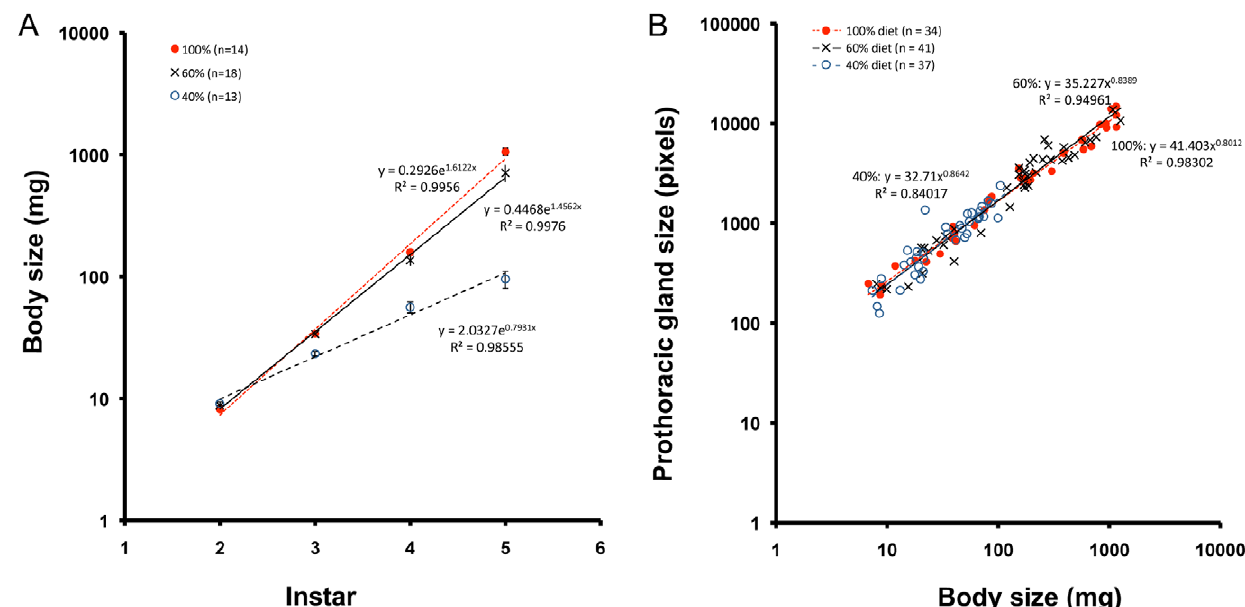
Figure 5. Effect of diet dilution on the timing of a molt and the growth of prothoracic glands. (A) Size of larvae at the time of head capsule slippage in larvae fed 40%, 60% or 100% diet from the first instar. (B) The relationship between body size and prothoracic gland size in larvae fed diluted diet from the first instar. doi:10.1371/journal.pone.0044429.g005 additional factors from the brain, or 2) cause the prothoracic glands to become competent to respond to brain derived factors.